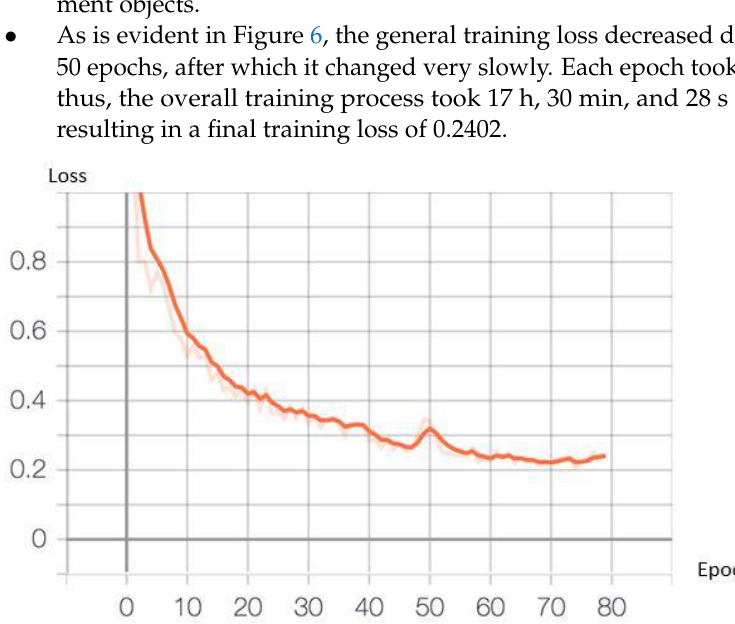
Figure 6. The general training loss of the Mask R-CNN model per epoch.